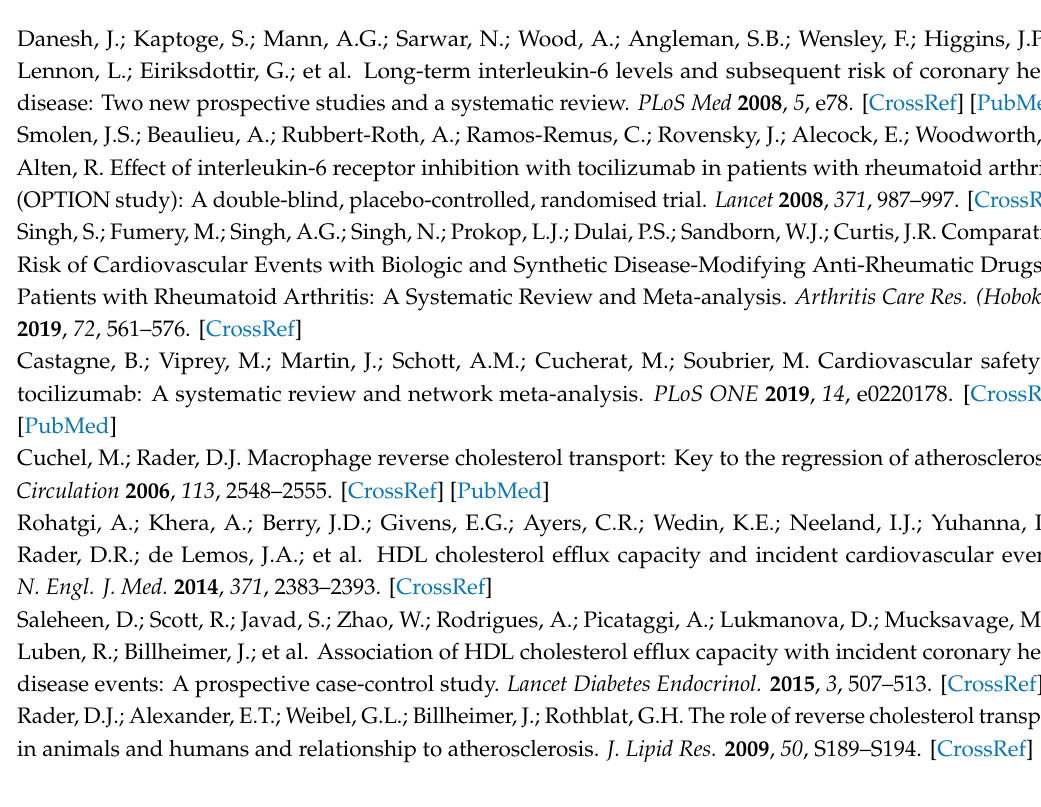
Table S1: Baseline demographic and clinical characteristics of patients with established rheumatoid arthritis starting tocilizumab, Table S2: Lipid profile of patients with established rheumatoid arthritis before and after 12 weeks from starting tocilizumab